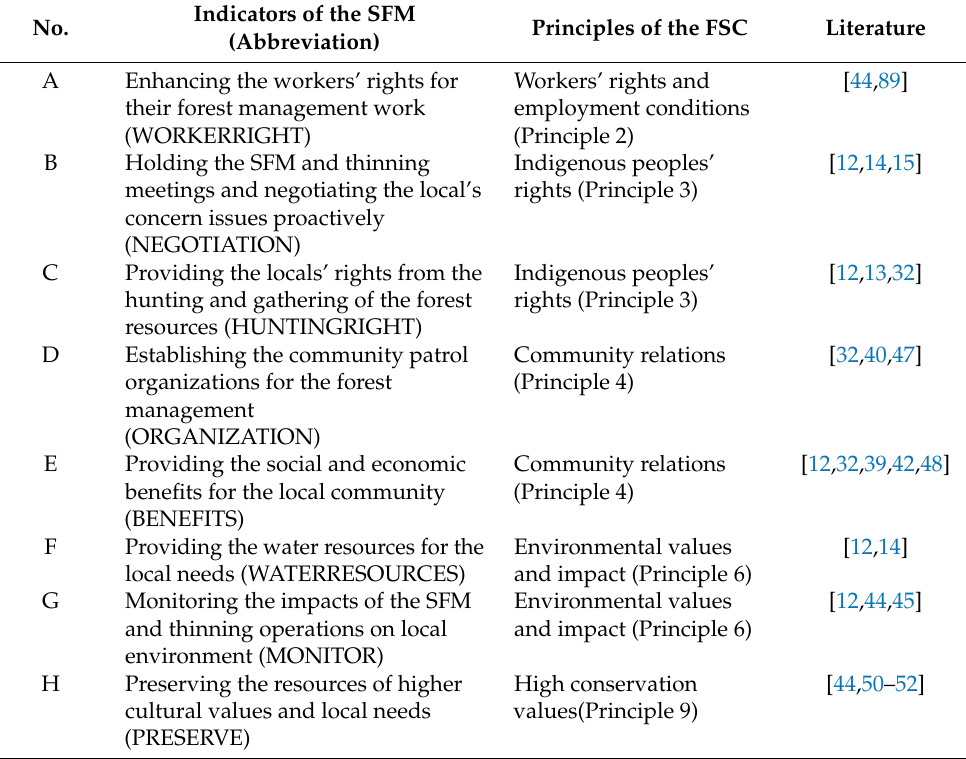
Table 1. Sustainable forest management (SFM) index corresponding to the Forest Stewardship Council (FSC)